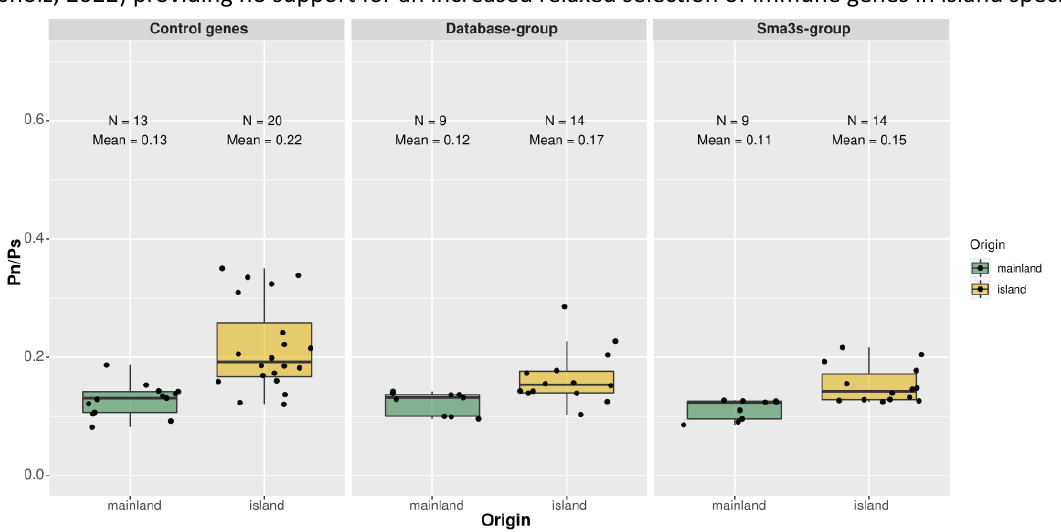
Figure 5: Boxplot of Pn/Ps according to species origin (mainland in green and insular in orange) for different gene categories under purifying selection. The number of individuals (N), and the mean Pn/Ps are shown for each